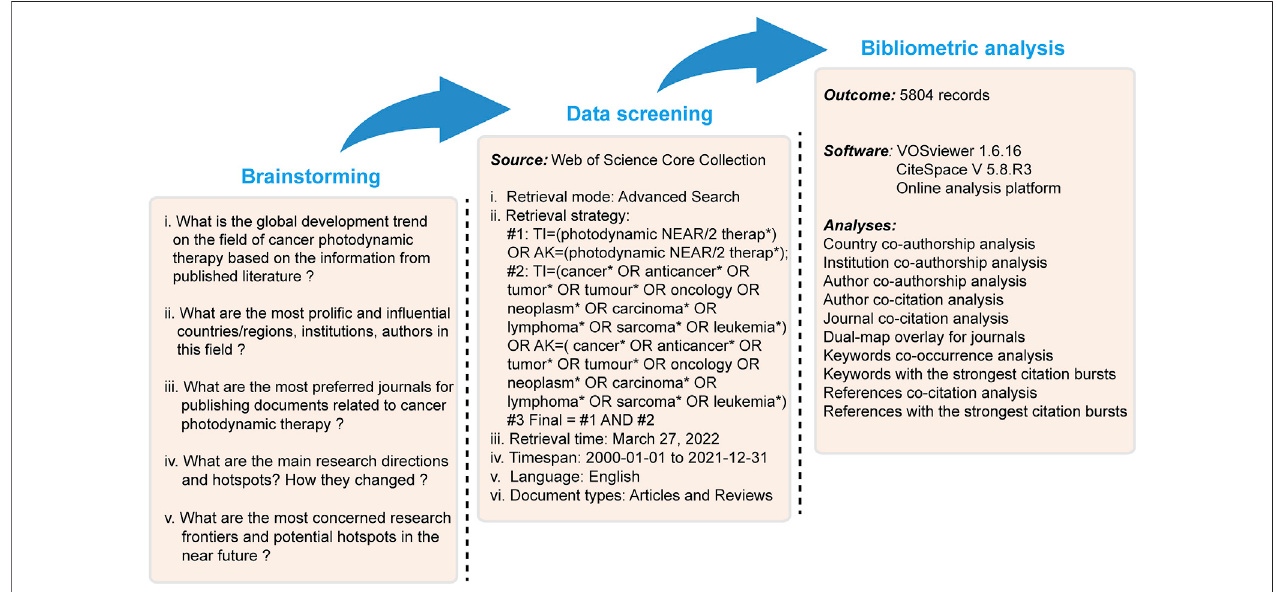
FIGURE 1 | Conceptual design and fl owchart of the